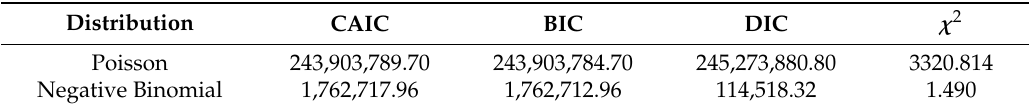
Table 4. The goodness-of-fit criteria for the claim number and size in the auto insurance portfolio in Ghana.